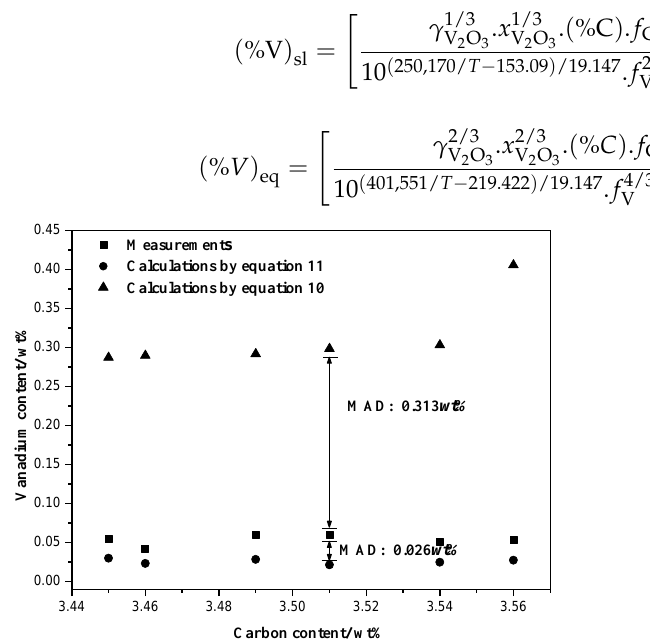
Figure 5. Theoretical vanadium contents and measuring values at the final.